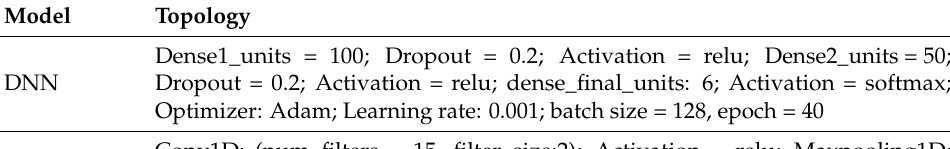
Table 3. Network architecture and hyperparameters of deep neural network models.